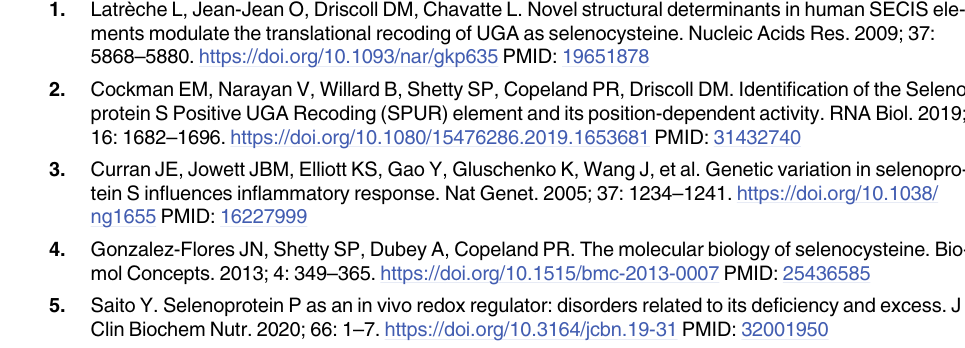
this manuscript. The numbers below gels correspond to loading order shown in